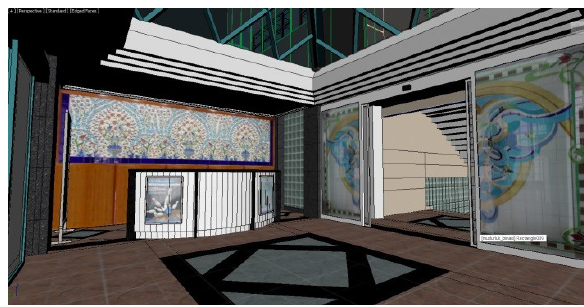
Figure 21: The 3D solid modelling - LoD4 More details explanation of the whole process of creating 3D city model for the Istanbul city as illustrated in the workflow in Appendix